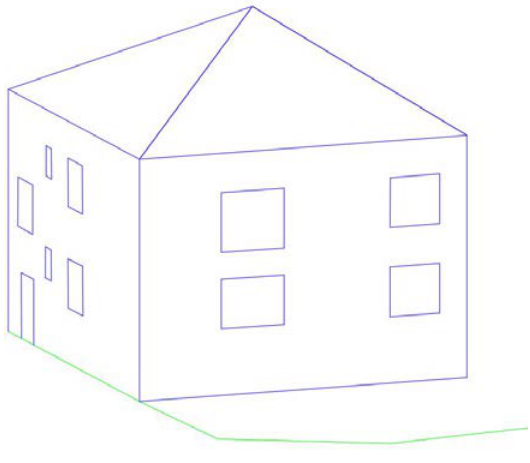
Figure 14: The buildings 3 and 4 in a parcel 68134.902.235